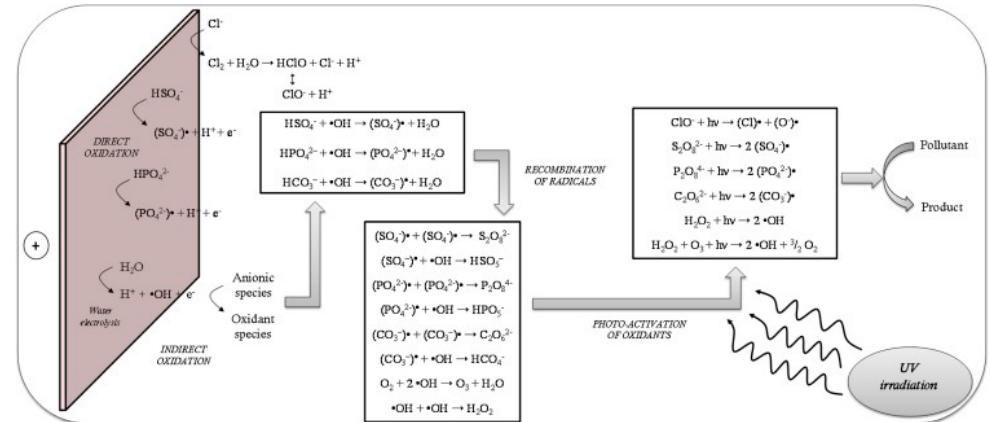
Figure 6. Mechanisms expected for the photo-electrolytic reclamation of secondarily treated wastewater. Reprinted with permission from ref [98]. Copyright 2016 Elsevier.